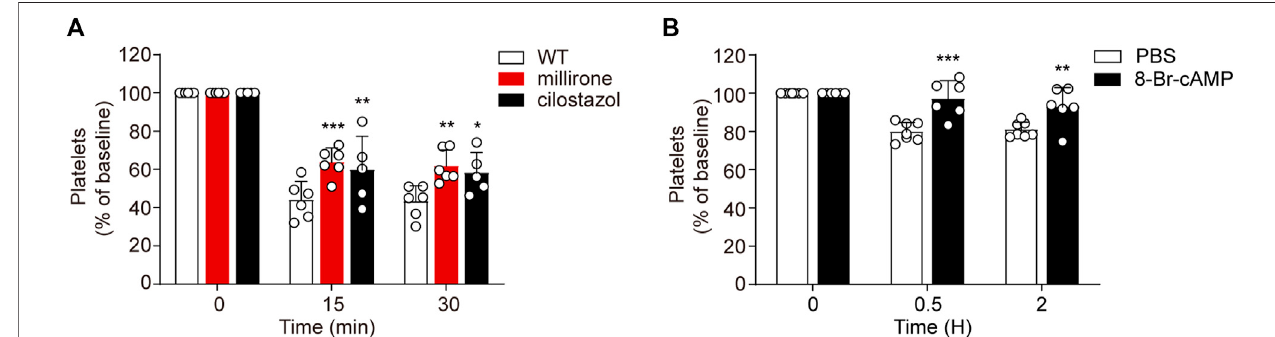
FIGURE7| UpregulatedPKAattenuatesCBZ-inducedthrombocytopenia. (A) Calcein-labeled mouse platelets pretreated with10 μ Mmilrinone, 10 μ Mcilostazol, orvehiclecontrolwereincubatedwith100 μ MCBZat37 ° Cfor2 HandthenweretransfusedtoC57BL/6Jmice.Thepercentageofcalcein-positiveplateletsremainingin circulation was assessed at the indicated time points by fl ow cytometry; n (cid:2) 6 for WT and milrinone group, and n (cid:2) 5 for cilostazol group. Baseline is de fi ned as the percentage of calcein-positive platelets immediately after transfusion. (B) C57BL/6J mice were injected with 2.5 mg/kg 8-Br-cAMP or PBS through the tail vein. After 30 min, 1.2 mg/kg CBZ was injected into the mice. Platelet counts were determined at the indicated time points. Platelet counts before injection is de fi ned as the baseline; n (cid:2) 7 for control, n (cid:2) 6 for 8-Br-cAMP treatment group. Data are mean ± SD; * p < 0.05, ** p < 0.01, *** p < 0.001 vs control group, two-way ANOVA prior to Bonferroni post hoc